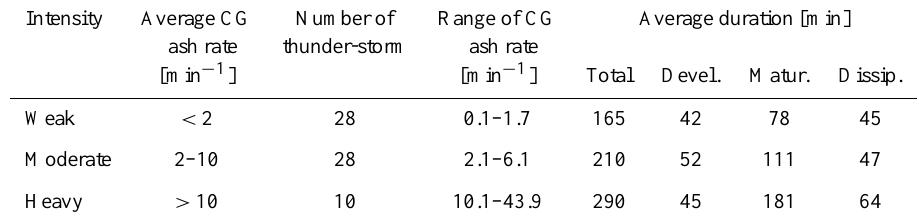
Table 2. Categories of the studied thunderstorms according to CG flash rate. Intensity